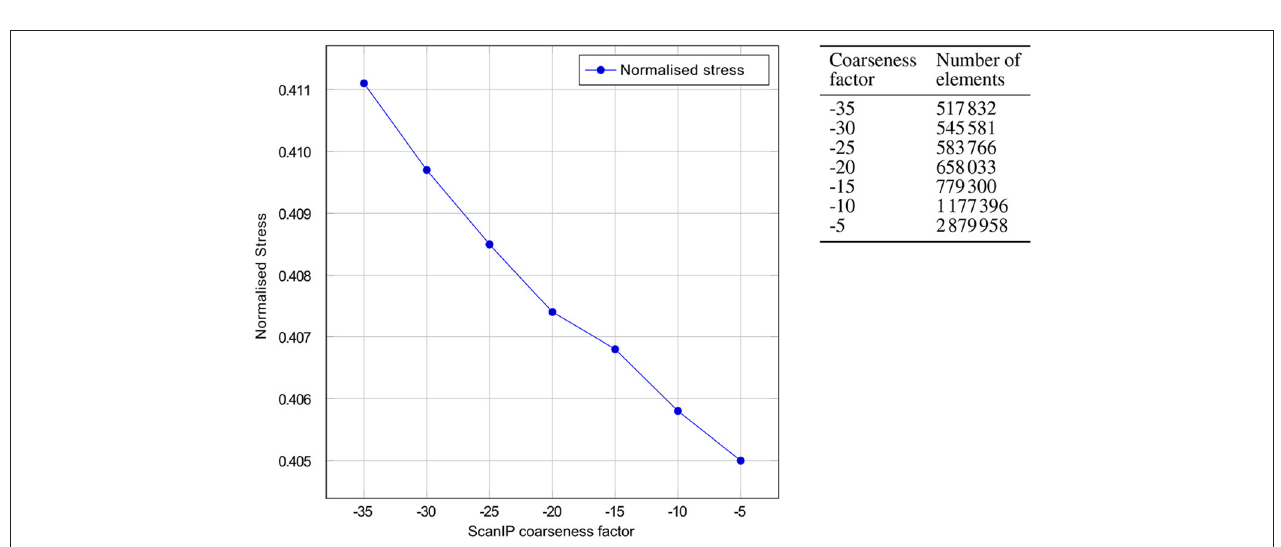
FIGURE 9 | Mesh convergence. Convergence of the normalised von Mises stresses of the residual limb model with decreasing ScanIP coarseness factor is shown. On the right, the number of linear tetrahedral elements in the FE model is tabulated against the ScanIP coarseness factors. The graph depicts the decrease in normalised stress with increase of mesh density, i.e., decreasing the mesh coarsening factor from